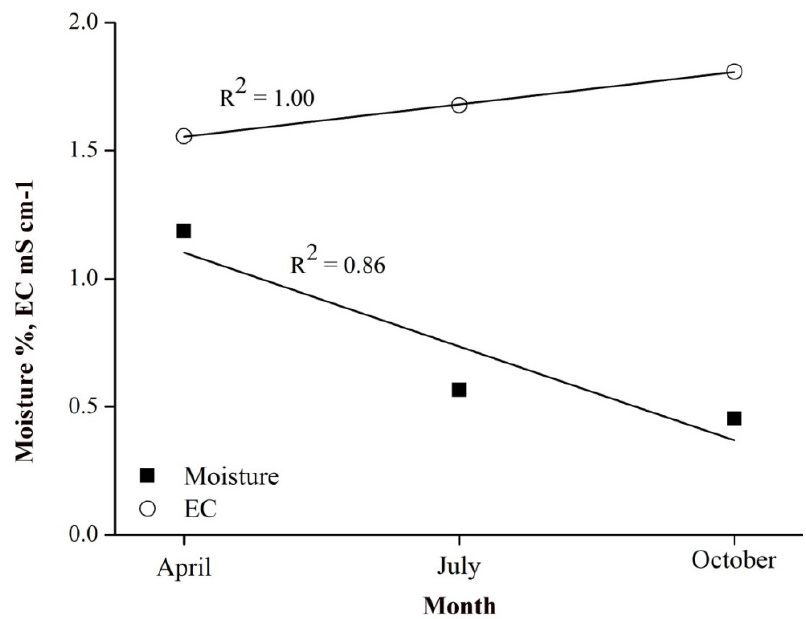
Figure 7. Ordinary kriged maps of soil moisture and EC during different seasons.